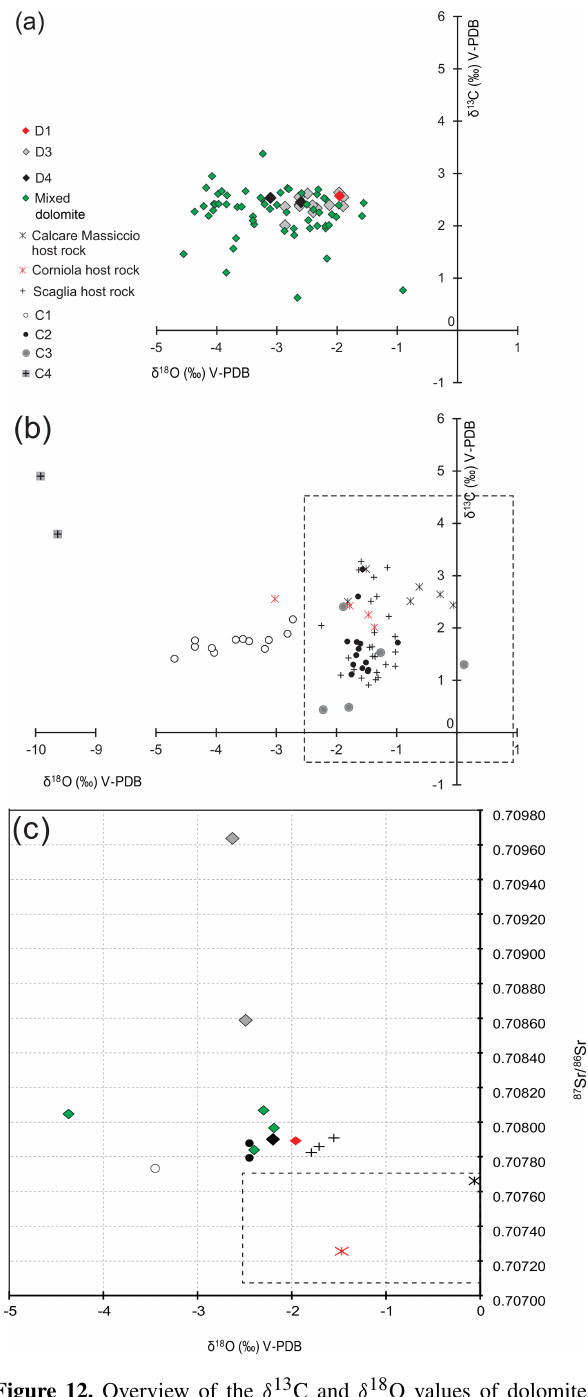
Figure 12. Overview of the δ 13 C and δ 18 O values of dolomites (a) host rocks from Montagna dei Fiori as well as calcite veins (b) . The stable isotope value of Lower Jurassic marine limestones based on Veizer et al. (1999) is indicated by a dashed rectangle in subset B. The δ 18 O values of the marine dolomites are considered to be 3‰– 4‰ V-PDB higher than those of marine limestones (Land, 1980; Major et al., 1992; Horita, 2014). (c) Cross plot of 87 Sr / 86 Sr ratios and corresponding δ 18 O values of host rocks, dolomites, and calcite veins compared with Lower Jurassic marine carbonates 87 Sr / 86 Sr (dashed rectangle) framework reported by McArthur et al.